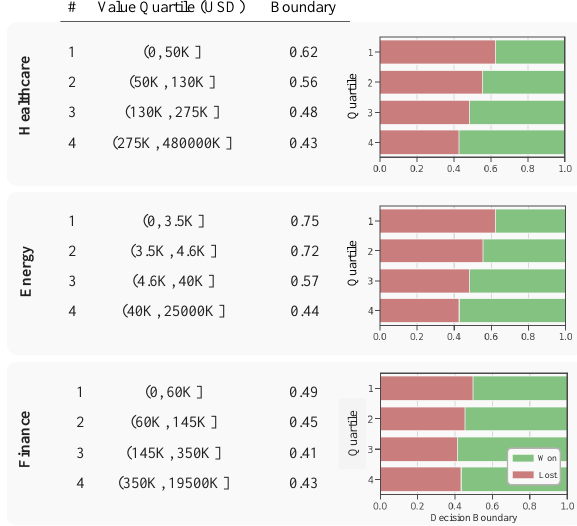
Figure 8. Decision